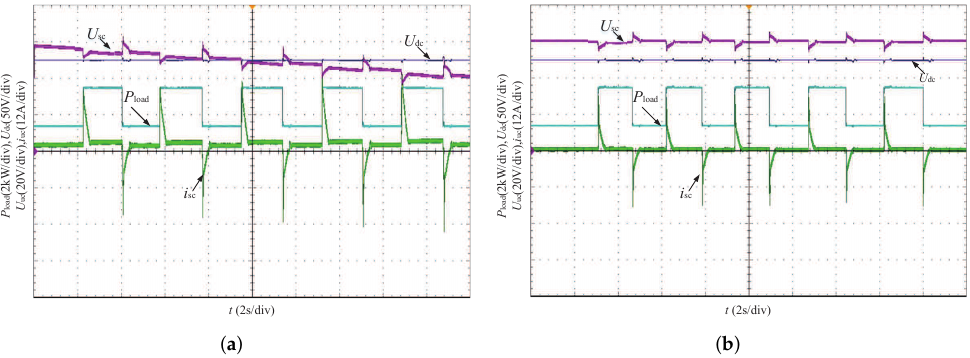
Figure 10. Experimental waveform chart with adaptive control of the SC terminal voltage: ( a ) without AEO; ( b ) with